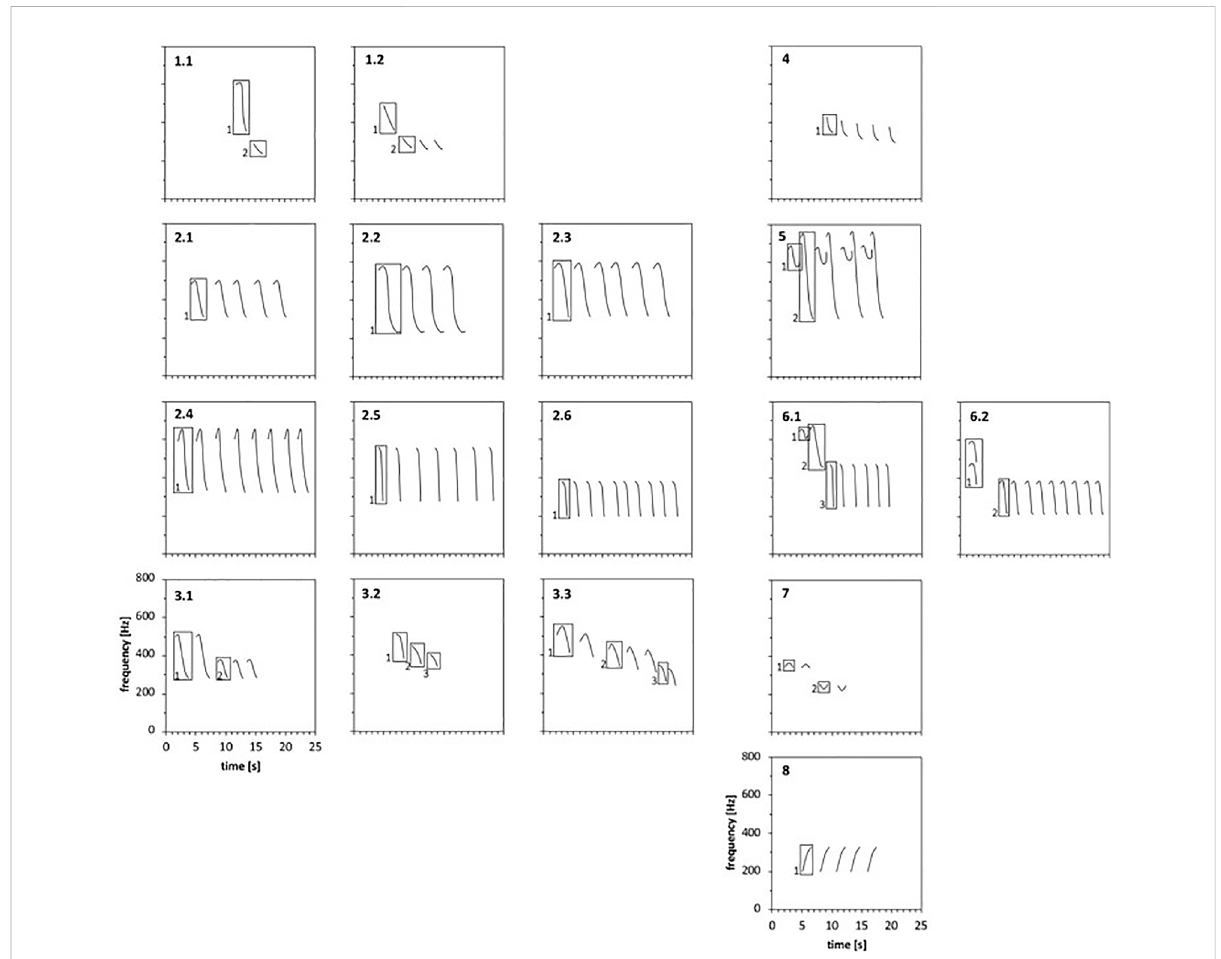
FIGURE 4 Idealized representations of the song types of bowhead whales recorded by E-2016 in eastern Fram Strait (79 ° 00.02 ′ N, 5 ° 40.12 ′ E) from November through May 2016/17. Song types (in rows, except for song type 2 which spans two rows) were numbered in their order of fi rst occurrence,andvariants(incolumns)ofthesongtypesareassignedasub-number.Differentsongunitsareencompassedbydifferentboxes.Please note that for each sub- fi gure, the x -axis comprises a time interval of 25 s and the y -axis represents the frequency range from 0 to 800